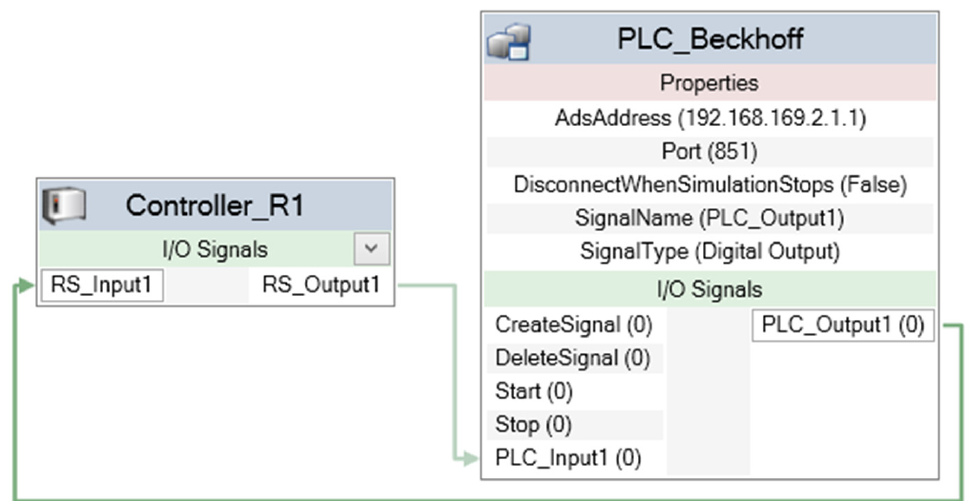
Figure 2. Usage of the developed PLC_Beckhoff SC in RS. Input/output signals from the PLC, i.e., PLC_Input1 and PLC_Output1, are exchanged with robot controller signals, i.e., RS_Input1 and RS_Output1, by establishing logic connections in the Logic Station panel of RS. The names of the signals defined in the PLC_Beckhoff SC coincide with the variable names in the PLC code.